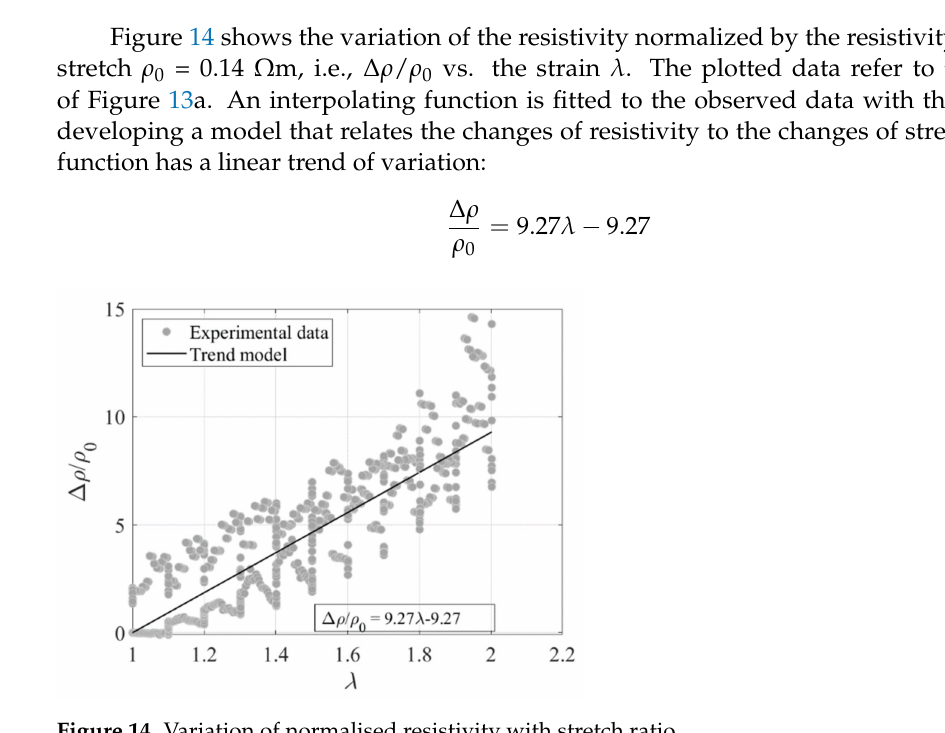
Figure 13. ( a ) Resistivity vs. extension ratio during 5th cycle, and ( b ) Resistivity vs. extension ratio during the 1st, 3rd and 5th loading cycles.